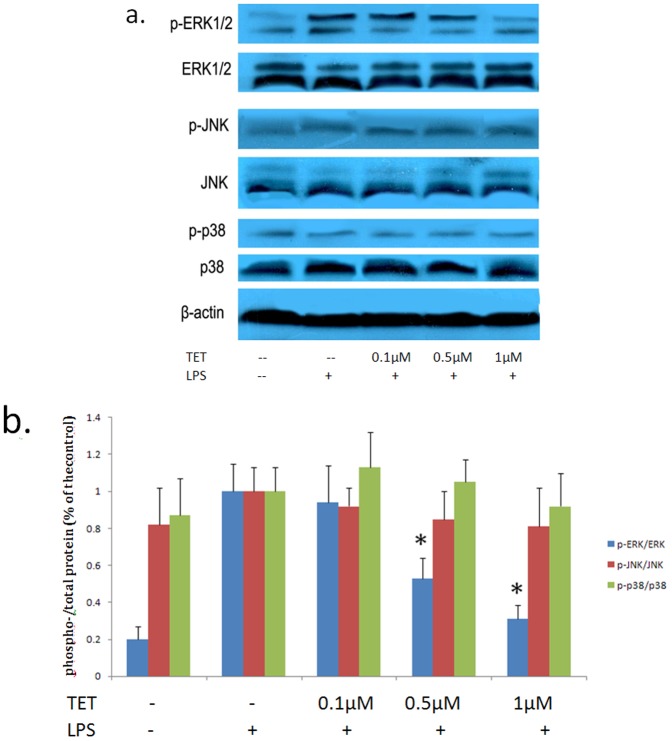
Effect of TET on LPS-stimulated MAPK activity in BV2 cells.BV2 cells were treated with TET at working concentrations for 2 h.Then, LPS was added to each plate and incubated at 37°C for an additional 24 h. Thereafter, the cells were lysed for protein extraction. Fig. 7a: Western blot assay was performed to evaluate the expression of total and phosphorylated forms of ERK1/2, JNK, and p38. β-actin was applied as the internal control. Fig. 7b: The ratio of densitometry values of total and phosphorylated forms of the protein was normalized to each respective control group. β-actin was applied as the internal control. Results were the mean ± S.D. from three independent experiments performed in triplicate. * P<0.05 compared with the LPS group.